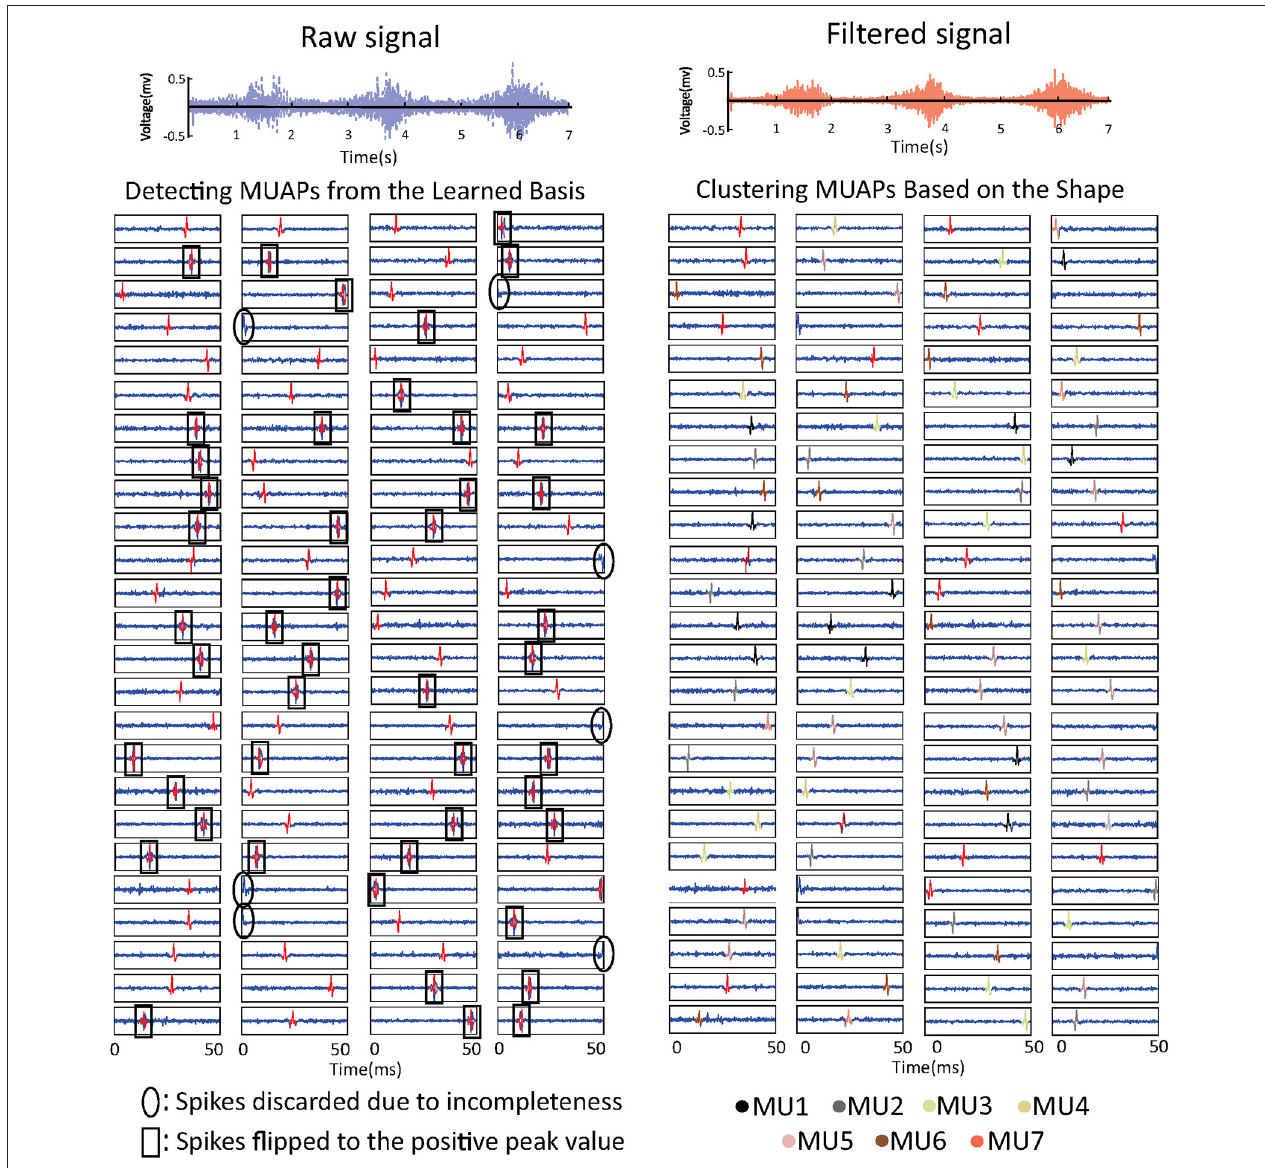
FIGURE 3 | sEMG signal decomposition: the raw sEMG signal (top left), the bandpass-filtered signal (top right), the detected MUAPs from the learned basis vectors (bottom left), and the clustered MUAPs (bottom